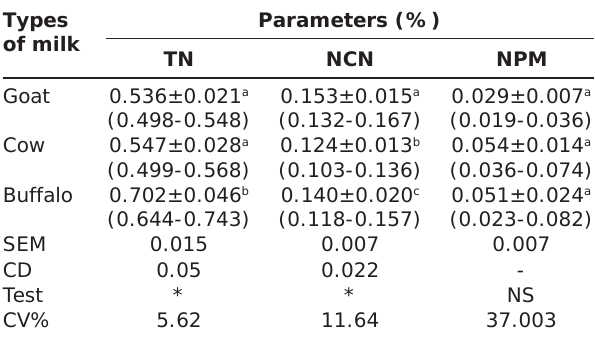
Table-2: Nitrogen distribution of goat, cow, and buffalo milk. Types of milk